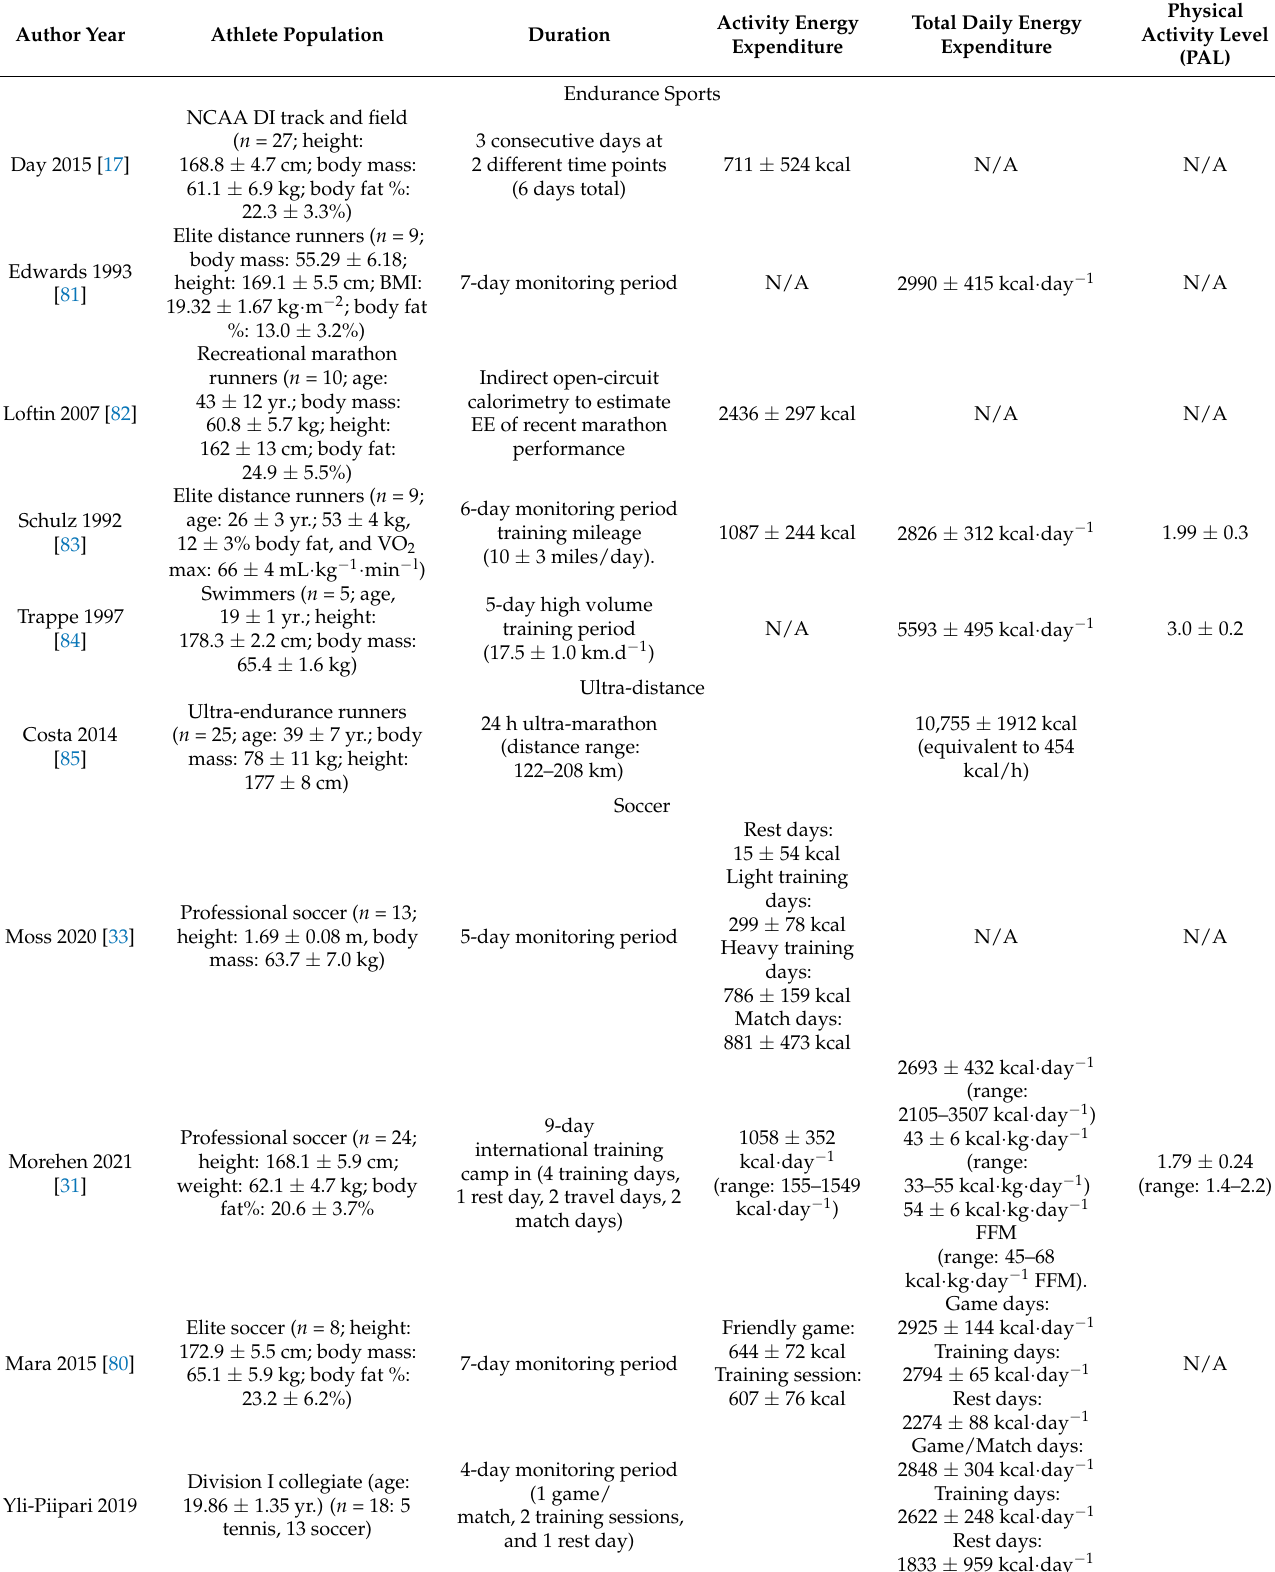
Table 3. Summary of activity and total daily energy expenditures of female